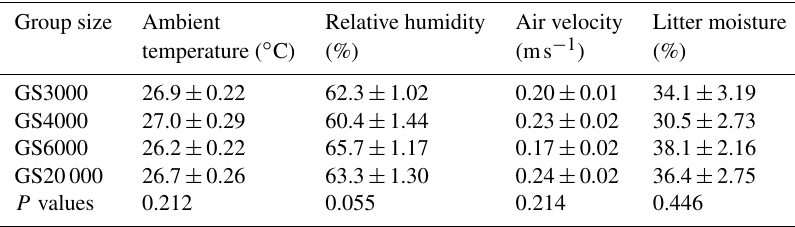
Table 5. Least square mean and standard error ( ± SE) of ambient temperature, relative humidity, air velocity, and litter moisture in the houses of broilers reared in varying group sizes ∗ .